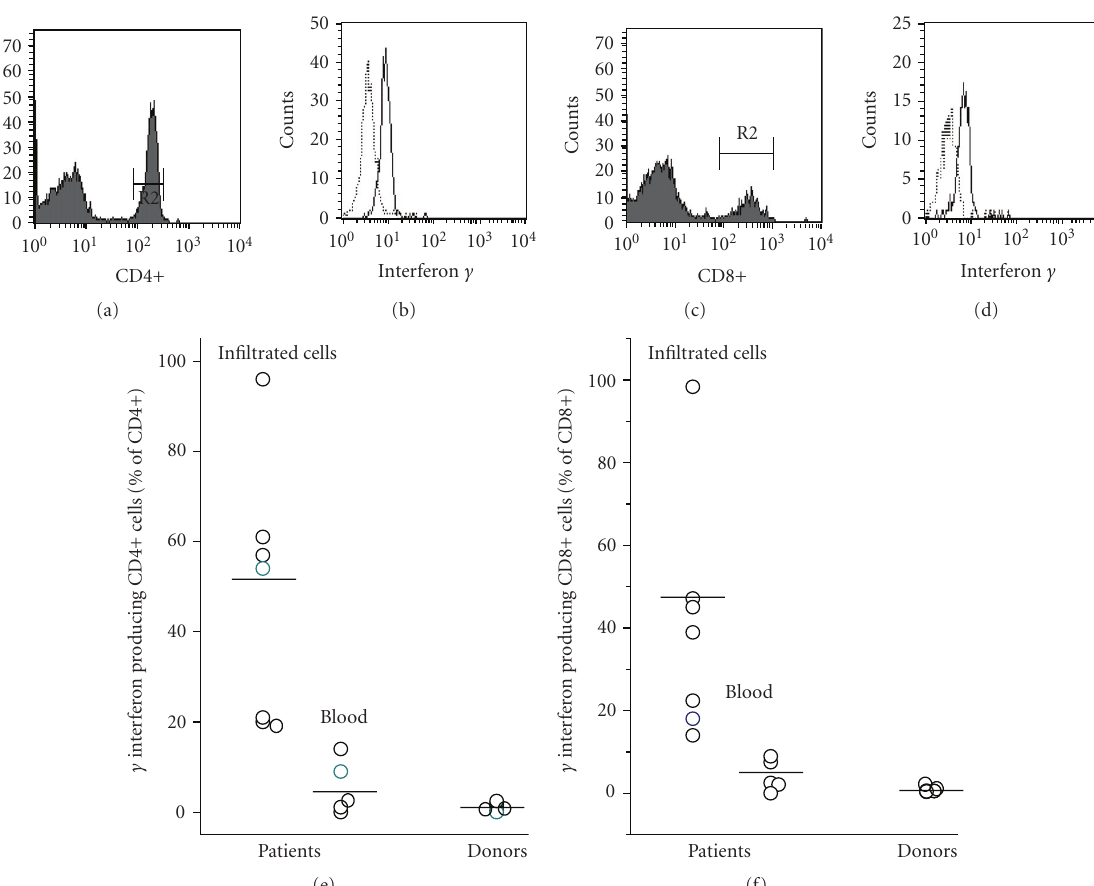
Figure 7: Synthesis of interferon γ by the infiltrated T cells. (a) The infiltrated T cells were recovered and cultured for 16 hours in the presence of brefeldin 1. The cells were permeabilised, and interferon γ was determined by cytofluorometry, as was CD4 and CD8. The gate was set for CD4+ or CD8+, respectively. Up to 90% of cells contained interferon γ. (b) Data of 7 patients are summarised. Shown are values obtained for the infiltrated T cells (local), for T cells of the peripheral blood of patients, and for healthy donors as well (di ff erences of the mean values were calculated by ANOVA and found to be di ff erent with a P < .